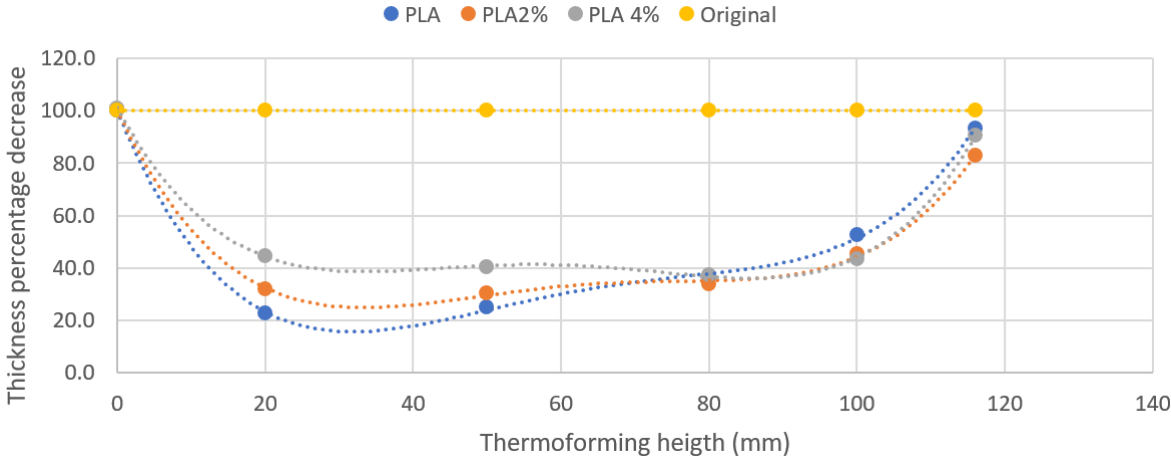
Figure 11. Experimental thickness of the central line of a thermoformed film against thermoforming height.